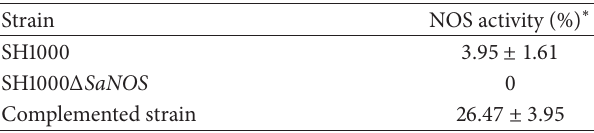
Table 2: Nitric oxide synthase activity in different S. aureus strains. Strain